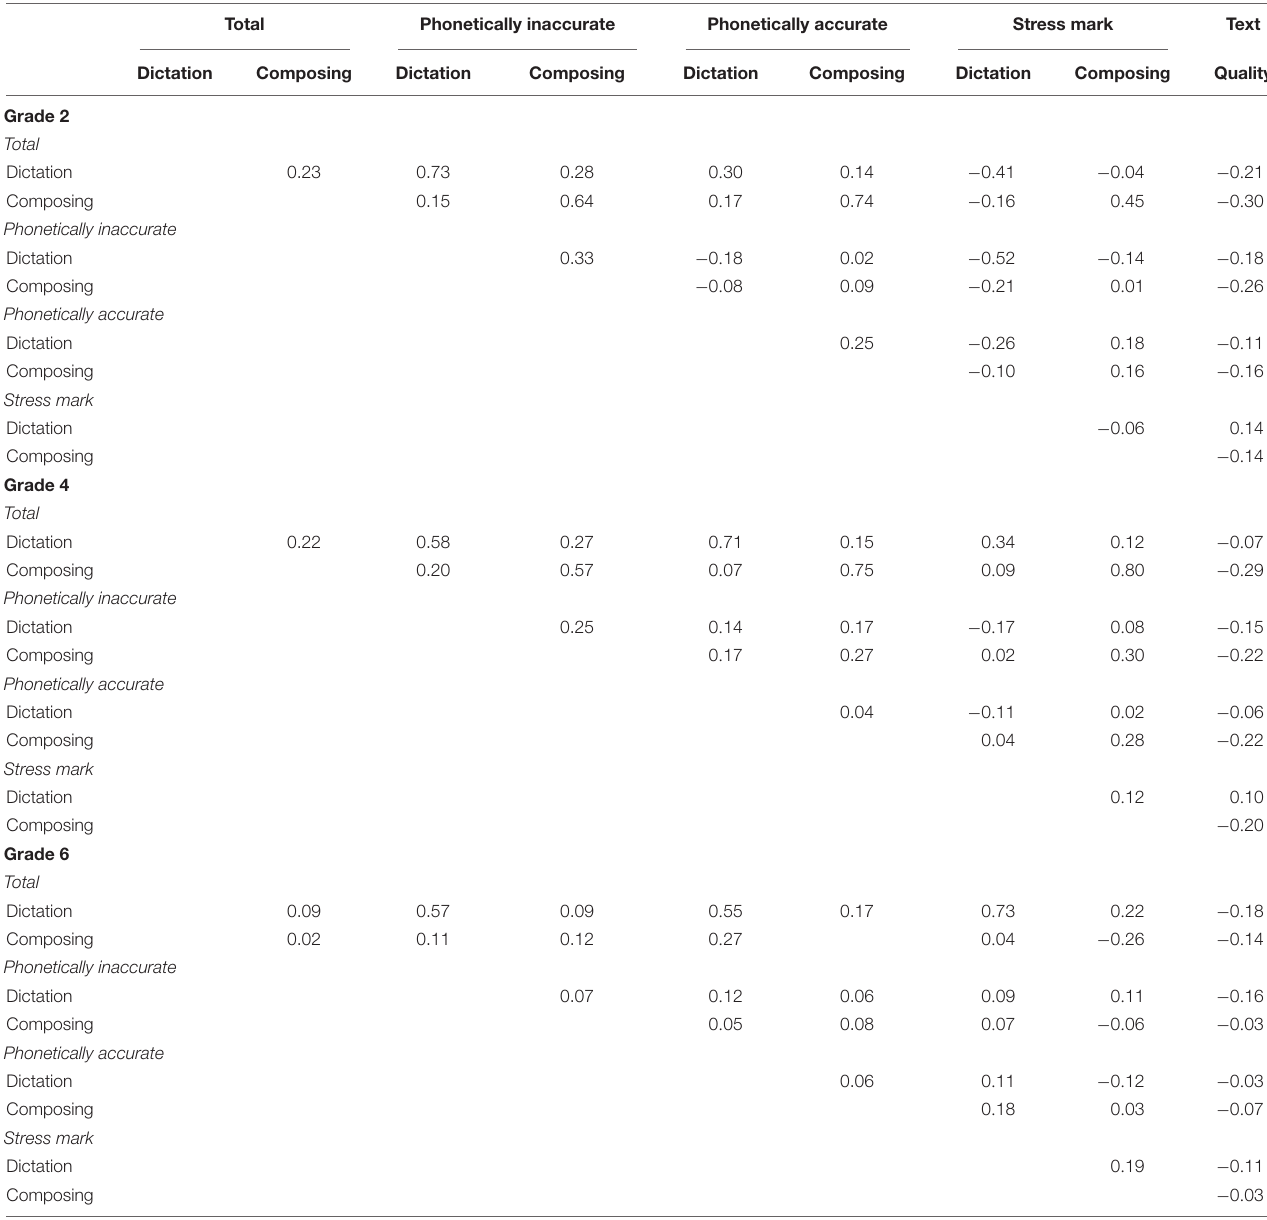
TABLE 2 | Correlations among misspellings in the dictation and composing tasks by grade. Total Phonetically inaccurate Phonetically